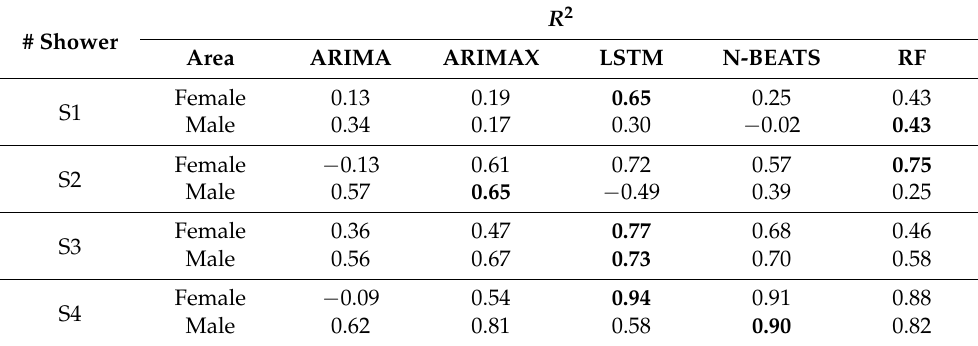
Table 7. R 2 of models (bold indicates the best result for the corresponding shower room and gender).